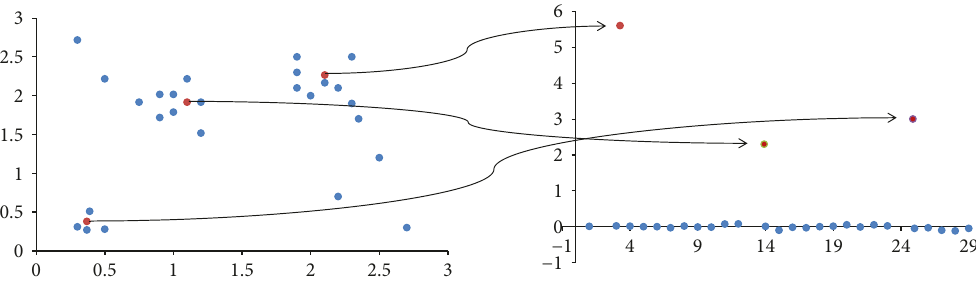
Figure 4: The corresponding points of centers.